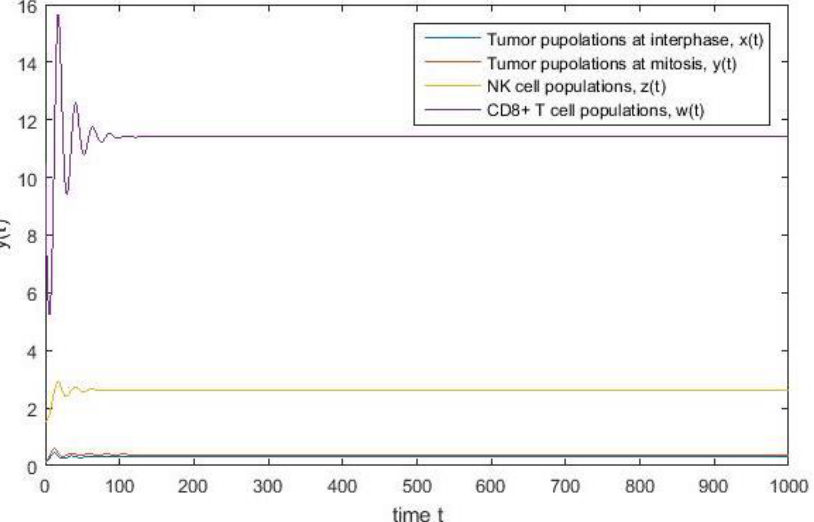
Figure 9. Tumour population with two immune response when τ = 0 at E 1 = ( 0.1,0.39,2.62,11.41 )